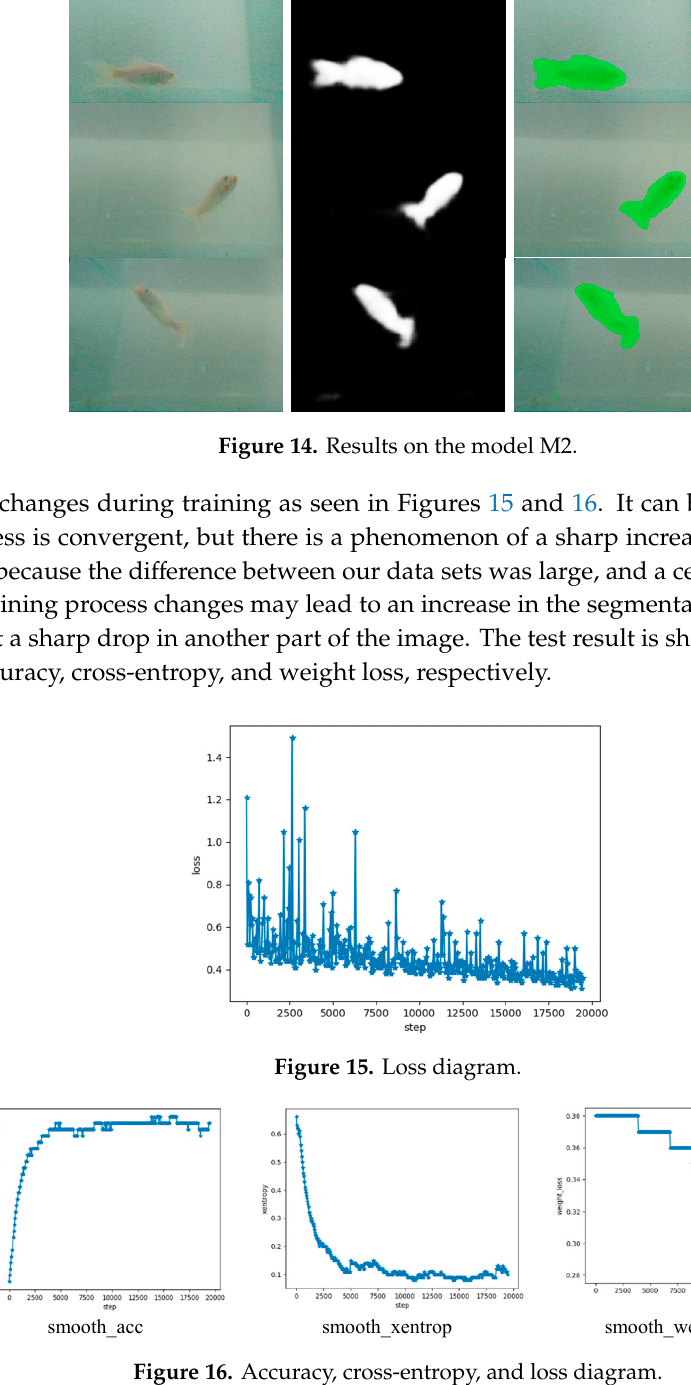
Figure 13. Results of the self-made data set on the model M1.